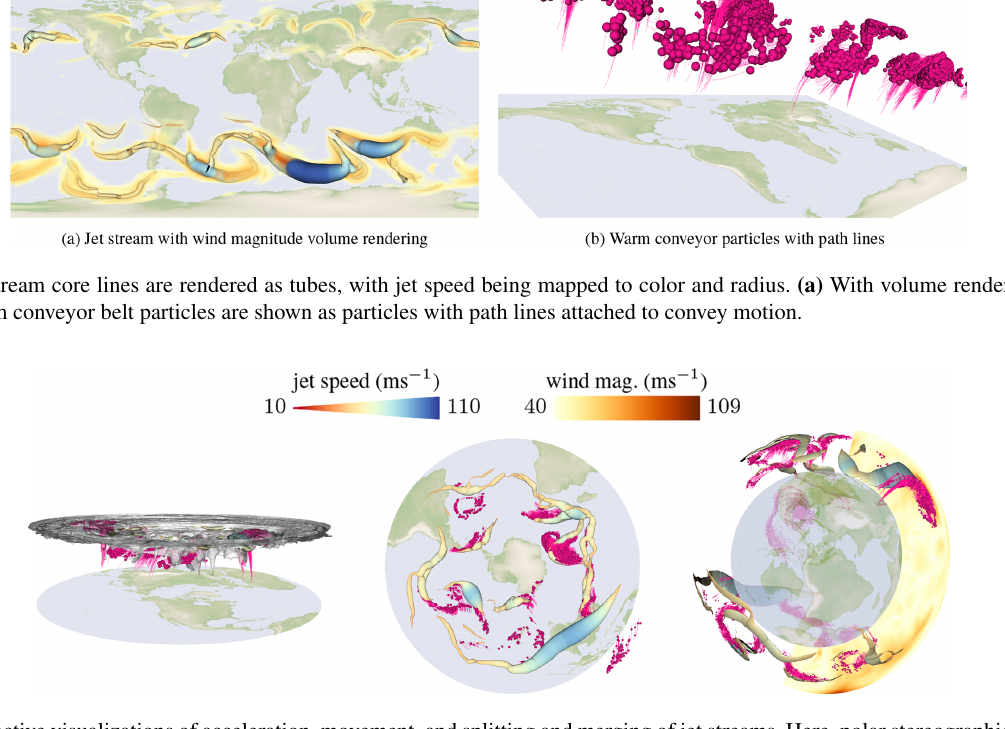
Figure 9. Interactive visualizations of acceleration, movement, and splitting and merging of jet streams. Here, polar stereographic projections of the tropopause, jet streams, and WCB outflows (magenta) for the Northern Hemisphere (left), Southern Hemisphere (middle), and a 3-D globe view with interactive volume slices (right) are shown. Jet speed is mapped to tube color and tube radius.